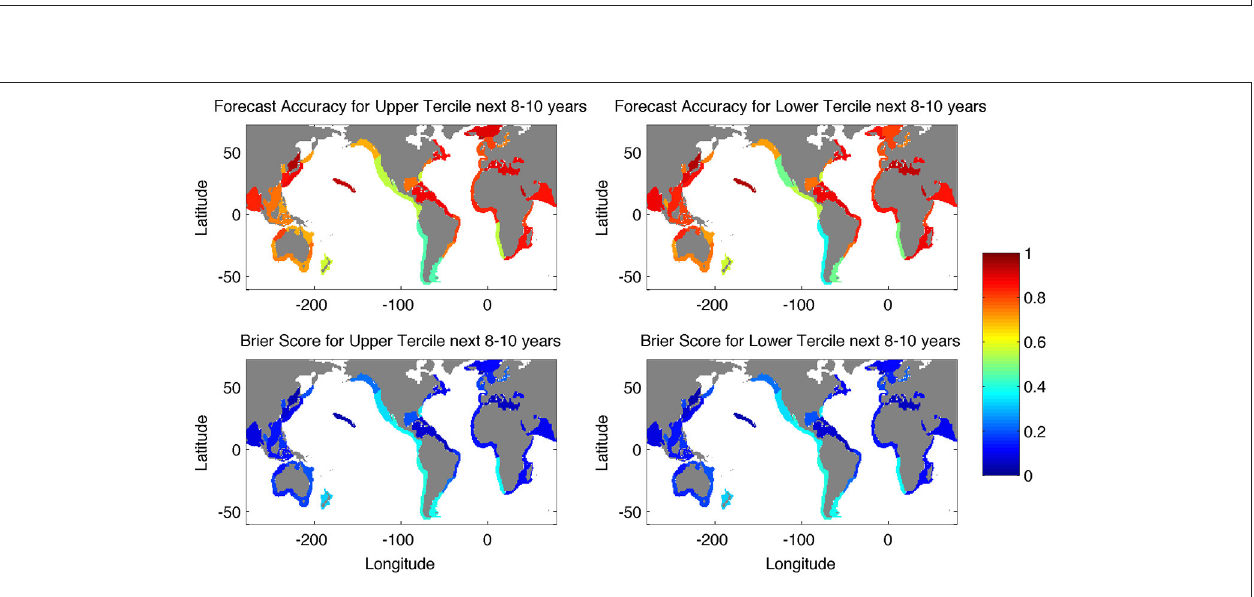
Frontiers in Marine Science | www.frontiersin.org